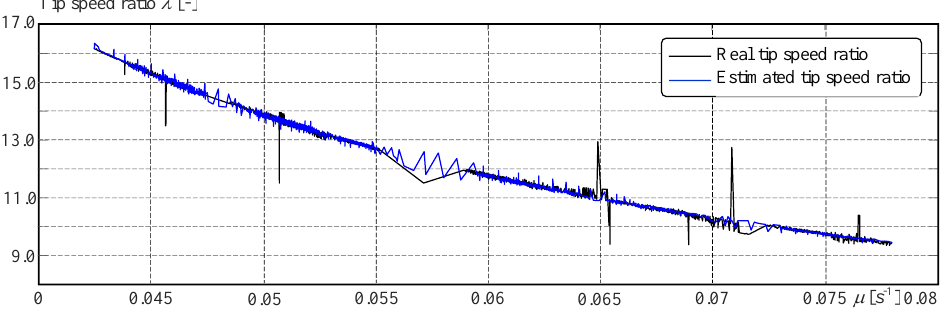
Figure 10. Single-side amplitude spectrum of the tip-speed ratio.